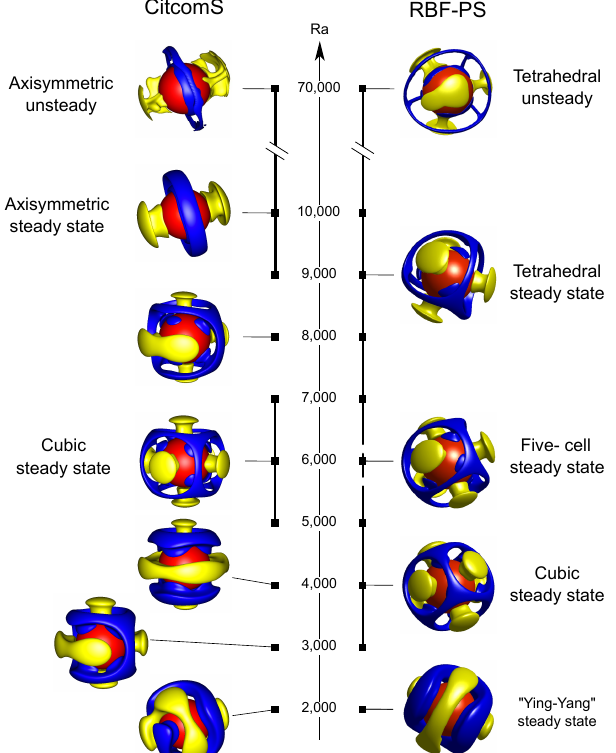
Figure 10. Transition of dodecahedral plume formation to different steady states for 2000 ≤ Ra ≤ 10 000 and to an unsteady state for 10000 < Ra ≤ 70 000 with the RBF-PS method (right column) and CitcomS (left column).